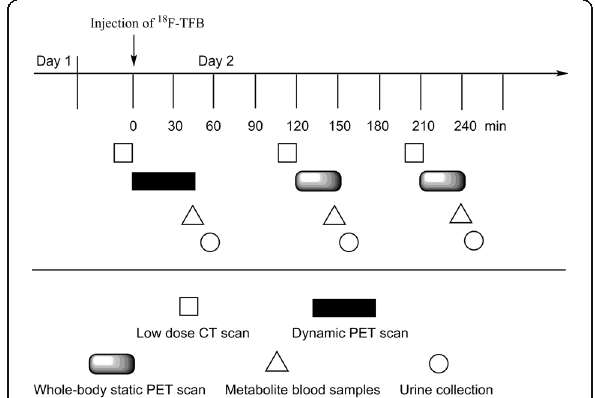
Fig. 1 Imaging protocol. Patients were screened on day 1 and imaged by 18 F-TFB-PET/CT on day